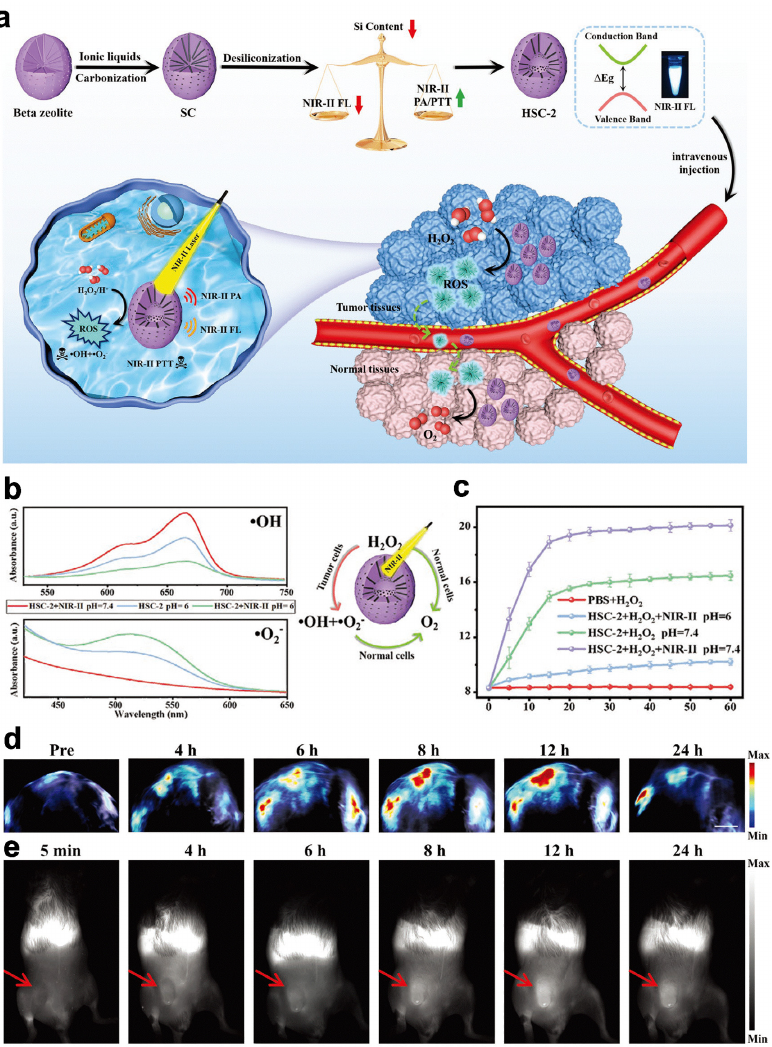
Figure 5. HSC-2 for NIR-II PA/NIR-II FL imaging. ( a ) Schematic illustration of adjustable photoacous- tic/fluorescence image-guided photothermal/catalytic therapy in the NIR-II window. ( b ) POD-like activity and ( c ) CAT-like activity of HSC-2 in different systems over time. ( d ) PA images of tumors in mice at different time points after intratumoral injection of HSC-2 (808 nm laser (0.3 W cm − 2 ) irradiation; 1064 nm). ( e ) NIR-II FL images of 4T1 tumor-bearing mice after systemic admin- istration of HSC-2 (1000 LP and 100 ms). Reproduced with permission from Ref. [107]. Copyright © 2021 Wiley-VCH GmbH.